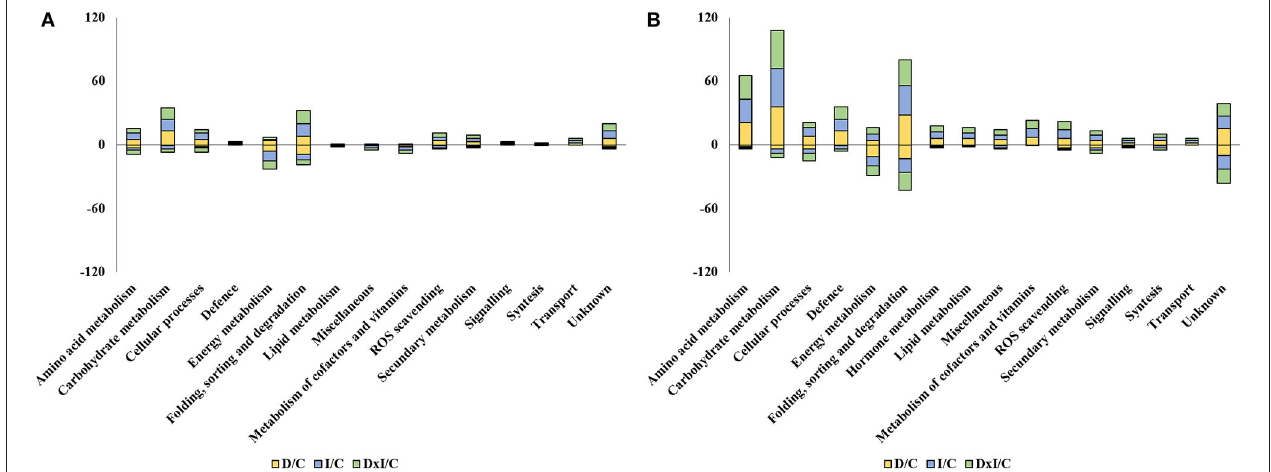
FIGURE 6 | Number of up- and down-accumulated variable proteins whose abundance in the drought (D), inoculation (I), and combined (D × I) treatments was greater or less than with the control treatment (C) in the Seville (A) and Almeria (B) populations. The numbers of up- and down-accumulated proteins are shown as positive and negative values, respectively.